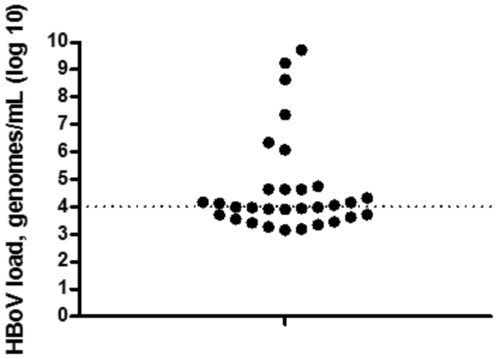
Distribution of human bocavirus (HBoV) viral loads.Thirty one respiratory aspirate samples were tested positive for HBoV. Each sample is represented by a single dot. Viral loads in the nasopharyngeal aspirates ranged from <500 to 1×109 copies per mL of sample material. The dotted line indicates the cutoff between the high (>104 copies/mL) and low (<104 copies/mL) HBoV viral load groups.